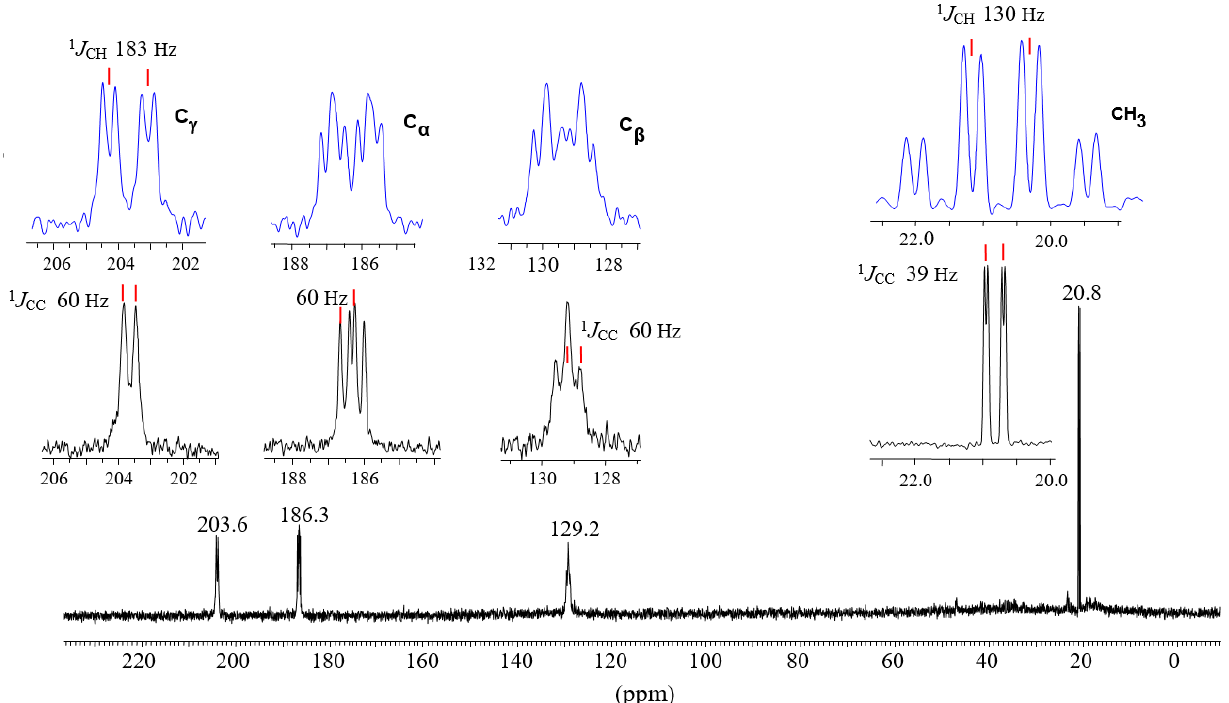
Scheme 4. The joining of HCl to the cation ( VI ) with the formation of cation ( VII ).